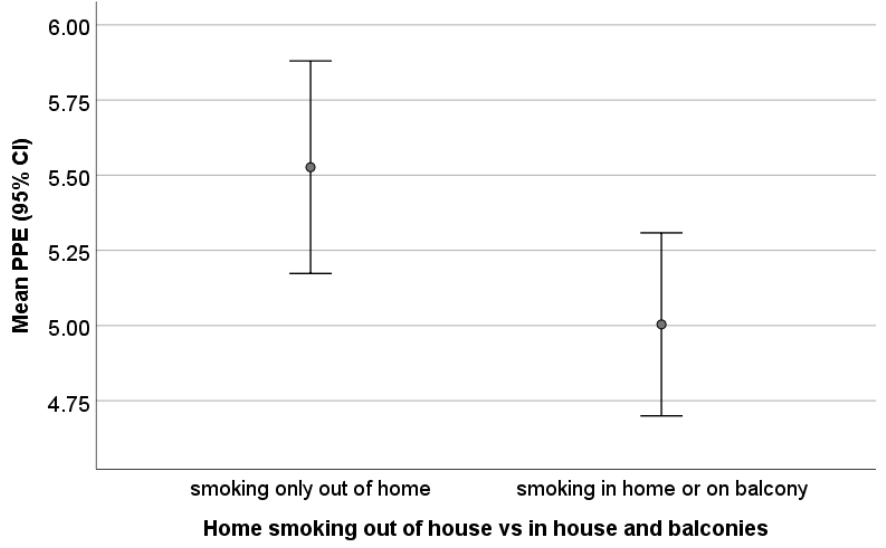
Table 2. Differences in PPE by home smoking location.